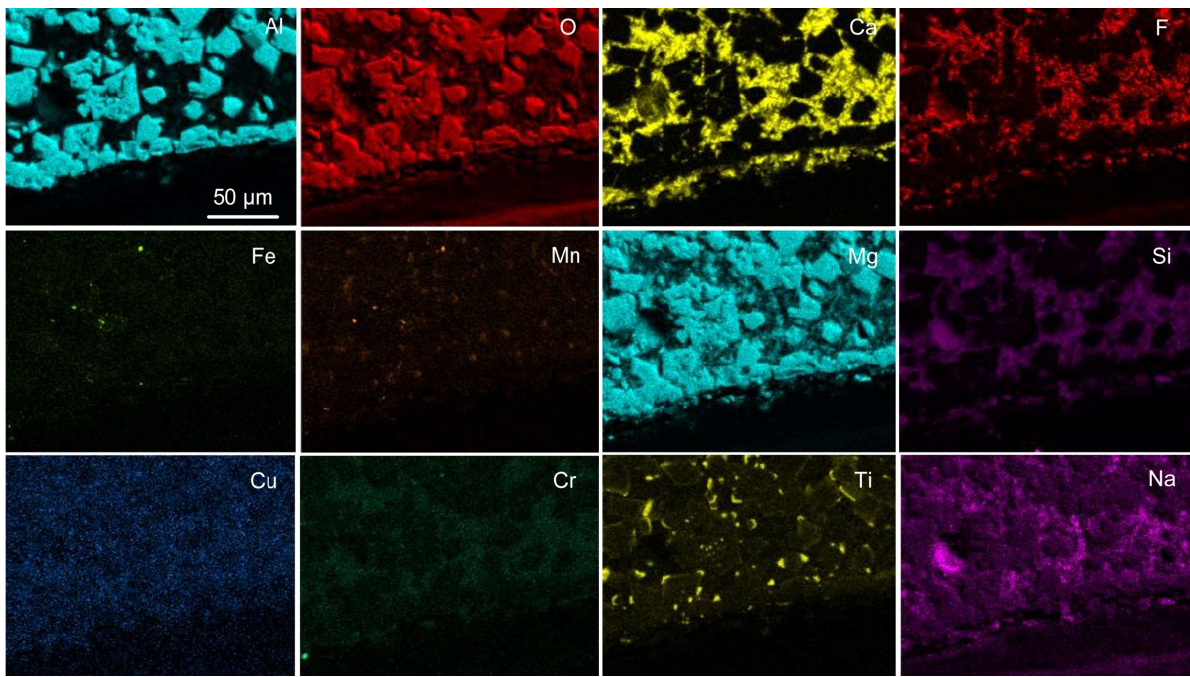
Figure 16. EDX map sample area in Figure 13c: MP5 slag sample.